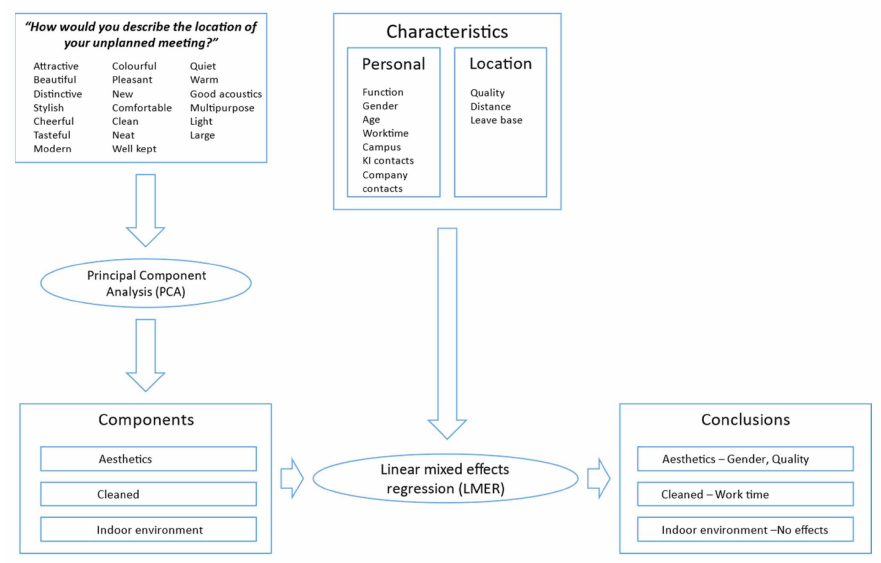
Scheme 2. Locations—Scheme of analysis with principal component analysis (PCA) and linear regression analysis